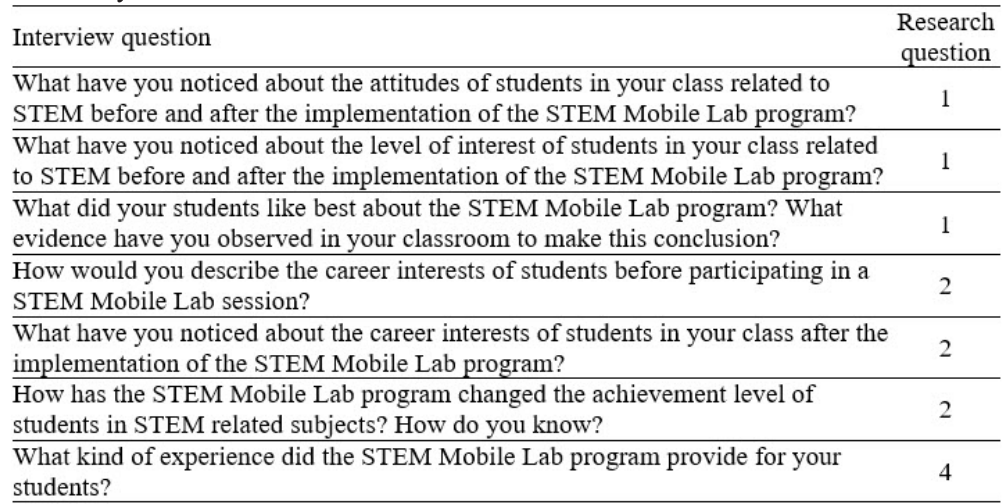
Table 1. Teacher structured interview questions and the alignment to the research ques- tions of the study